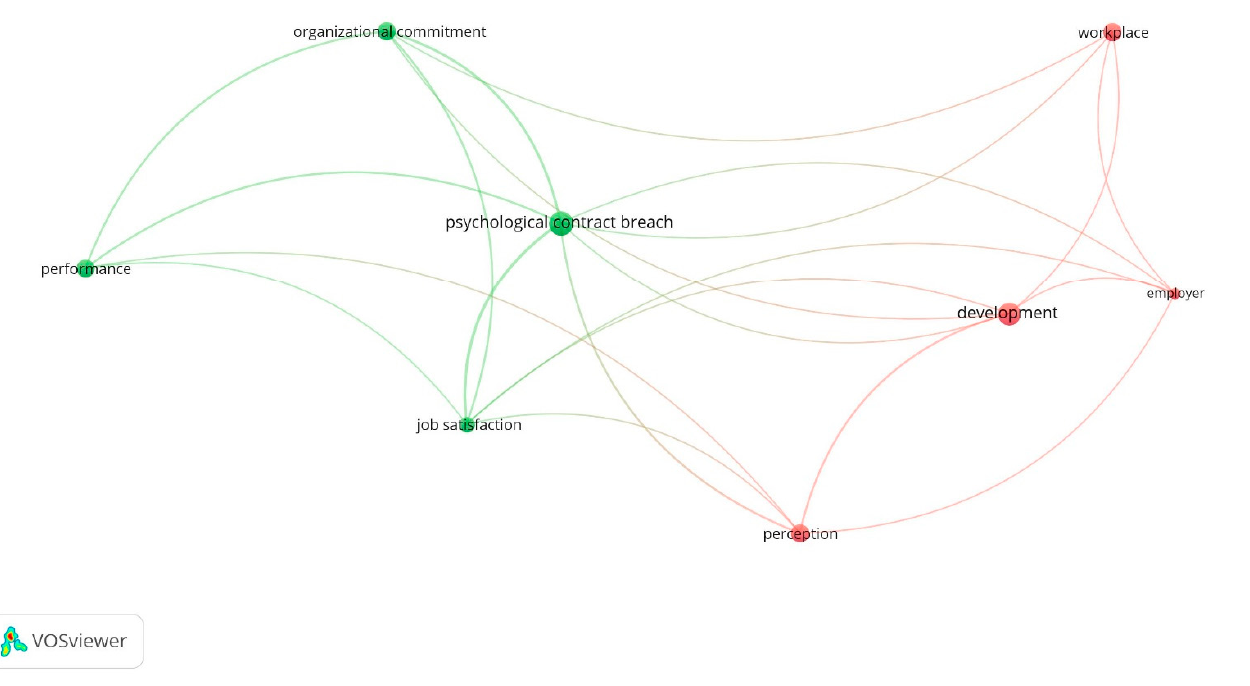
Figure 2. Network map created from the review articles included in this systematic revision using VOSwiever software. Titles, keywords, and abstracts were employed to extract the significant terms.